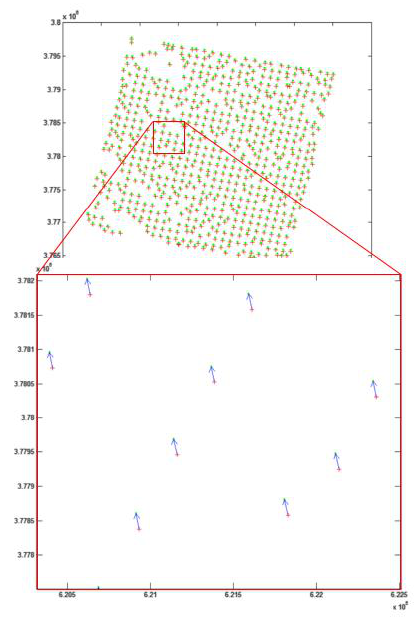
Figure 5. Shift between SRTM and